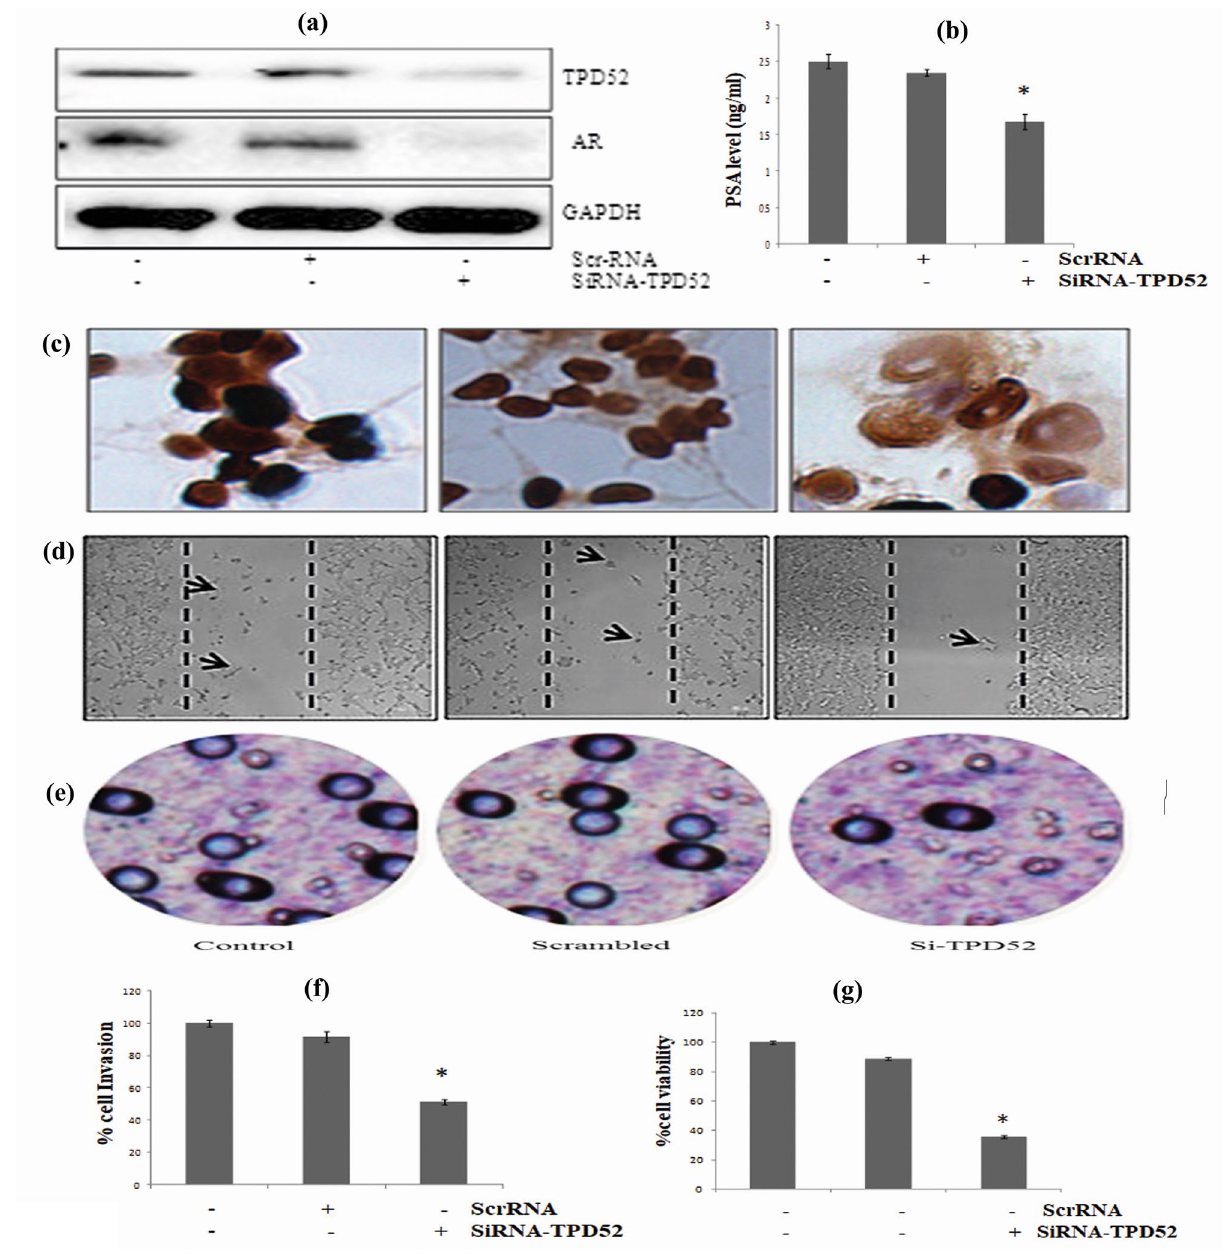
Figure 8. ( a ) Silencing of TPD52 in CWR22Rν1 cells. Western blot analysis of TPD52 protein expression in siRNA-TPD52 transfected CWR22Rν1 cells. The total cell lysate was prepared and 40 μg protein was subjected to SDS-page followed by Immunoblot analysis and chemiluminescence detection. The blots shown here are representative of three independent experiments with similar results. ( b ) Effect of downregulation of TPD52 on the proliferation rate of 22Rv1 cells. 3-(4, 5-dimethylthiazol-2-yl)-2, 5-diphenyl-tetrazolium bromide (MTT) assays were performed after downregulation of TPD52 in 22Rv1 cells. Downregulation of TPD52 leads to decreased cell proliferation as compared to control untransfected and scrambled RNA transfected cells. ( c ) Immunohistochemistry of TPD52-siRNA down-regulated CWR22Rν1 cells. As TPD52 is localized mainly in the cytoplasm so brown (DAB) stain shows an expression of TPD52 and the blue counterstain (hematoxylin) represents the nucleus. The first left represents control untransfected CWR22Rν1 cells showing high staining of TPD52, the middle is scrambled RNA transfected cells also show staining close to normal cells and the third is SiRNA-TPD52 transfected CWR22Rν1 cells showing low to mild staining of TPD52. ( d ) Migration of TPD52- siRNA down-regulated CWR22Rν1 cells. As shown by microscopic analysis, the first left figure represents untransfected normal CWR22Rν1 cells showing almost 60% of migrated cells, the middle figure represents scrambled RNA transfected cells showing almost the same number of migrated cells as that of normal control and third is SiRNA-TPD52 transfected CWR22Rν1 cells which show only 10% of migrating